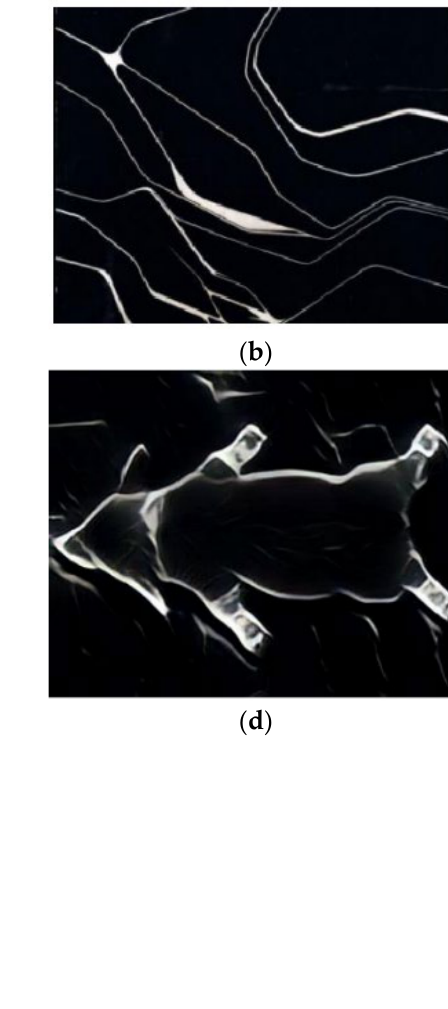
Figure 19. Image similarity with the variance of the images.